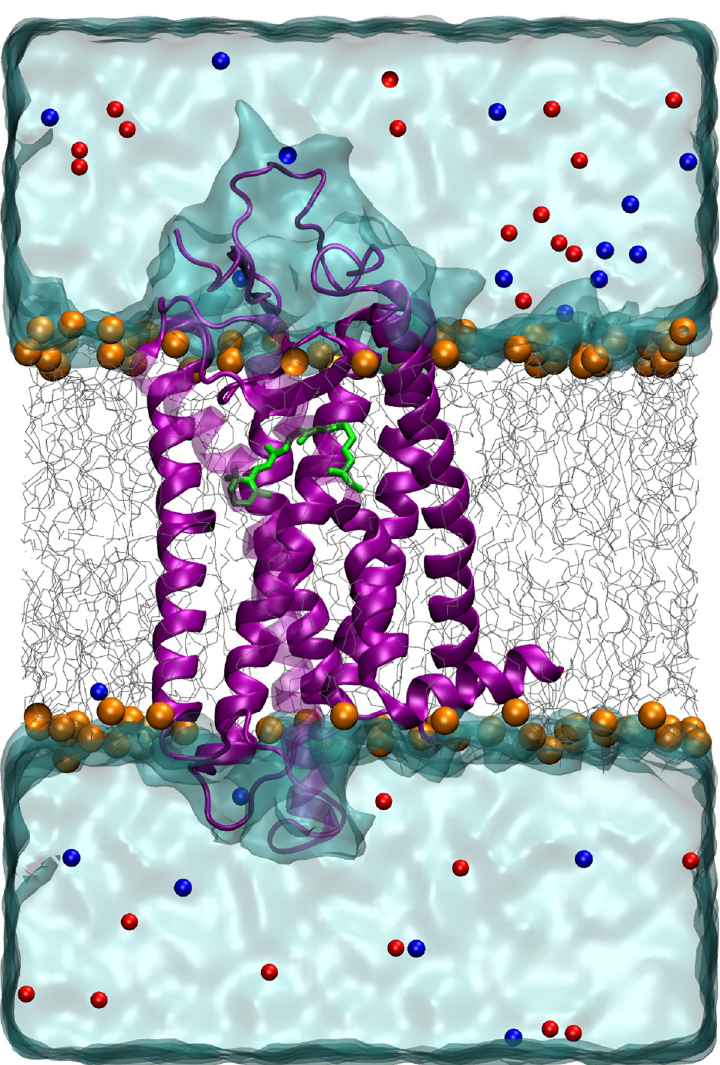
Fig 2. A representative 3D structure of Sws2 cone opsin ( λ max values < 430 nm) homology structure (violet) with the chromophore (green) bound covalently to K296 of the opsin protein. It is inserted in a phospholipid bilayer (gray, carbon atoms; orange, phosphorus atoms) and surrounded by water molecules (light blue). Blue and red spheres indicate positive and negative counter ions,